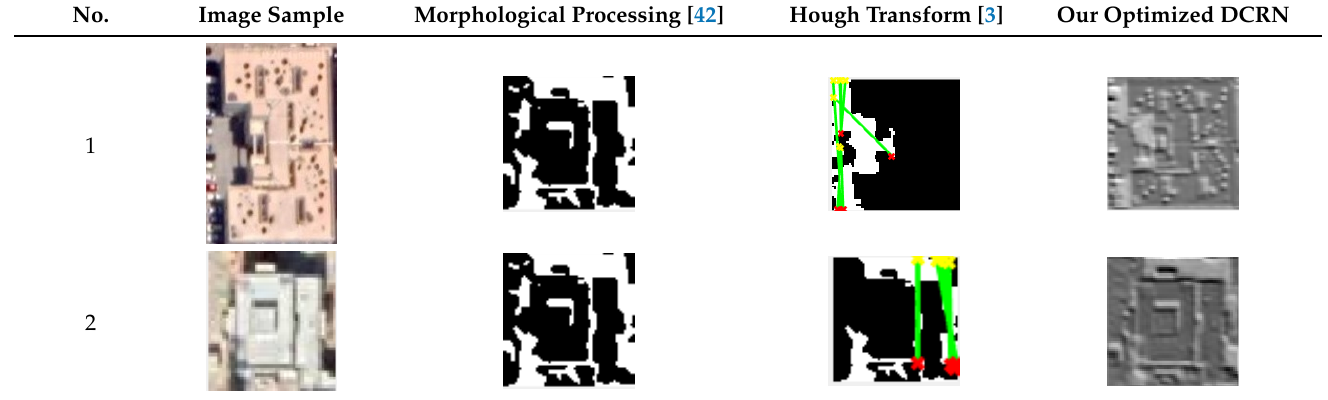
Table 10. The deep activation kernels of our proposed approach vs. traditional methods.